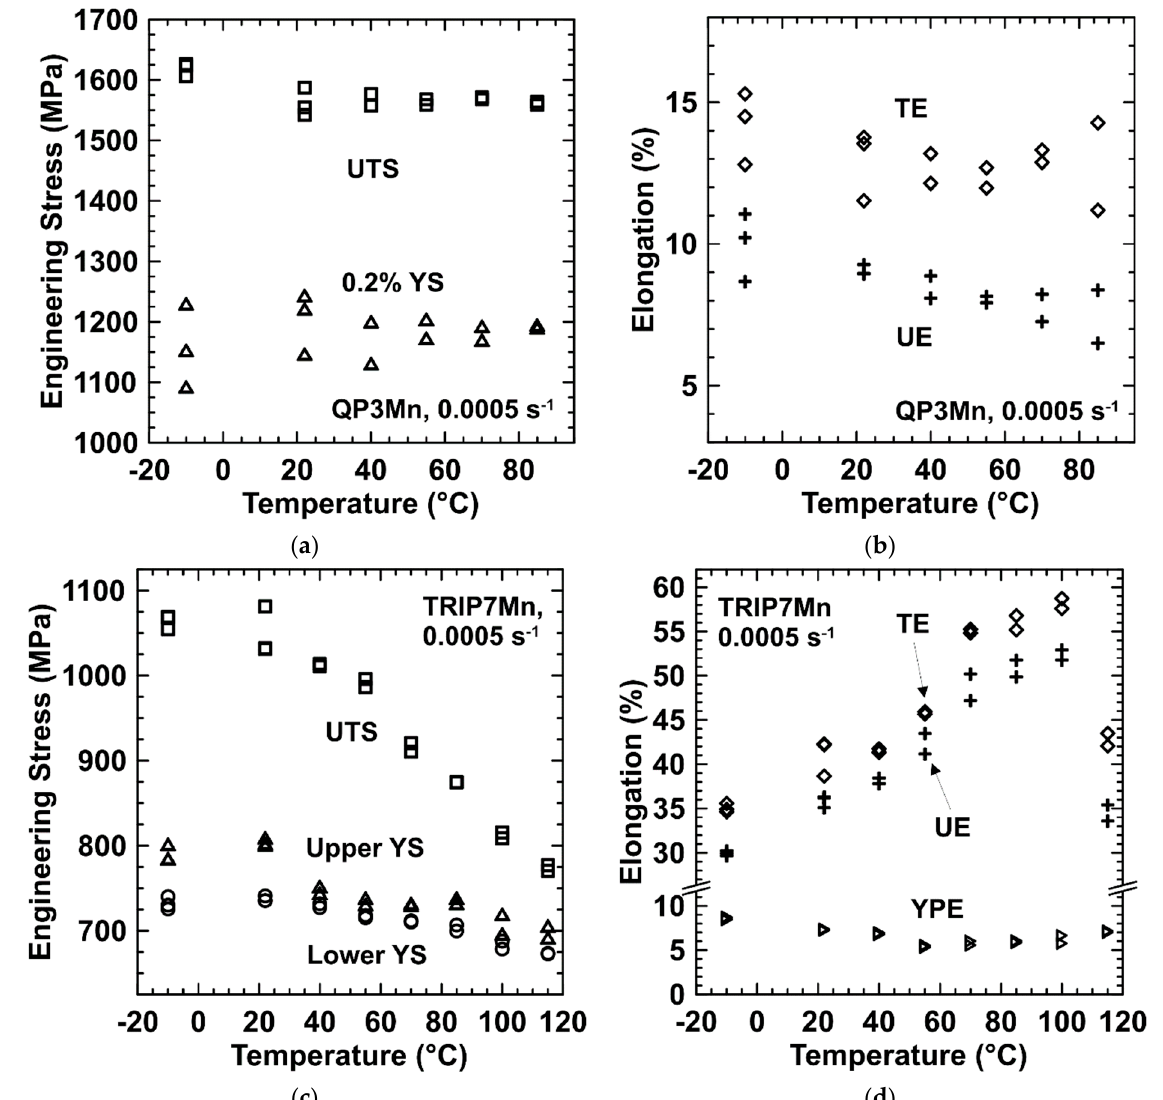
Figure 6. Tensile mechanical properties versus temperature from replicate tests at 0.0005 s − 1 . ( a ) QP3Mn 0.2% YS and UTS; ( b ) QP3Mn UE and TE; ( c ) TRIP7Mn lower YS, upper YS, and UTS; and ( d ) TRIP7Mn YPE, UE, and TE.